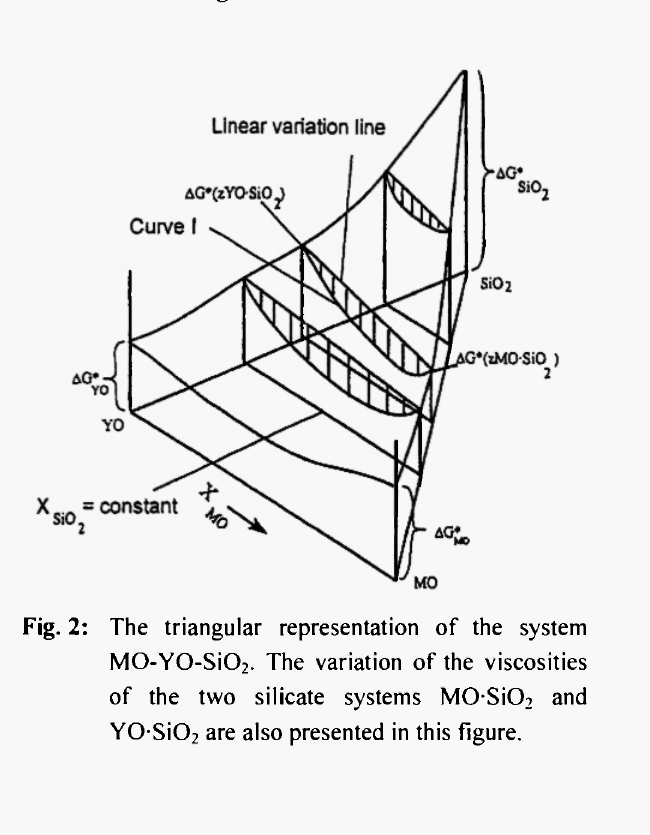
viscous flow. This is shown in Fig. 3, which illustrates the vertical section along the z - M 0 S i 0 2 - z - Y 0 S i 0 2 tie- line from Fig.